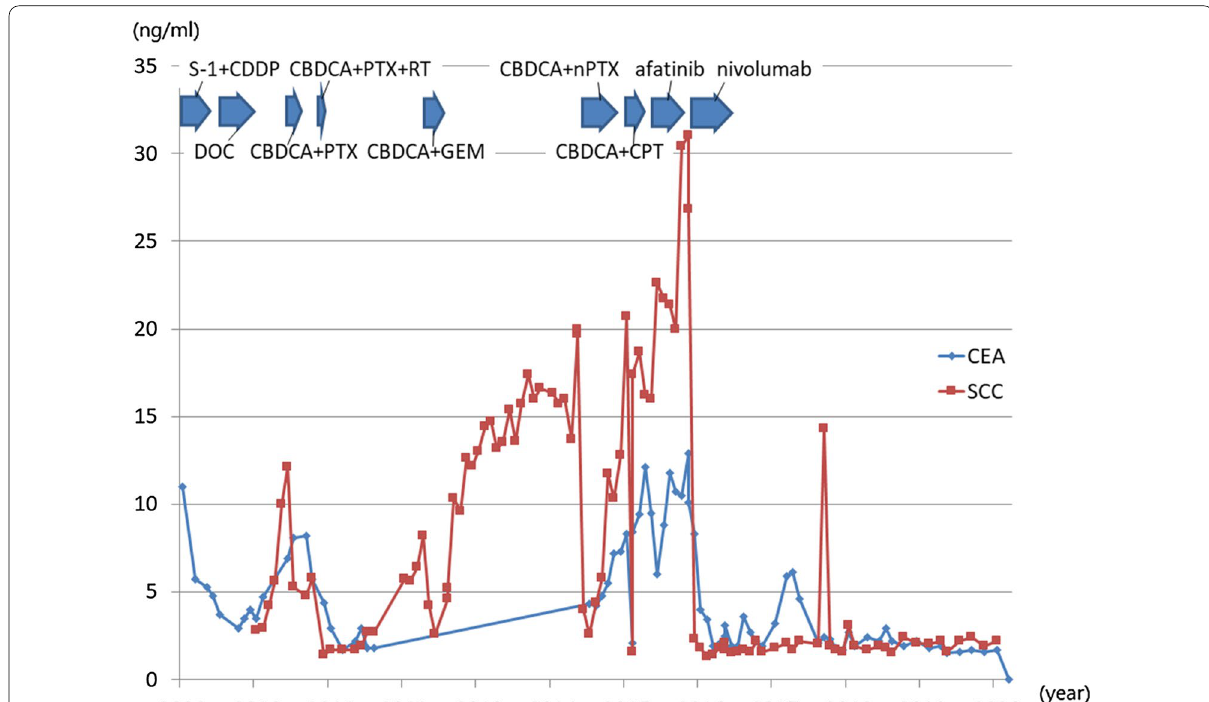
Fig. 3 Changes of tumor markers. CEA carcinoembryonic antigen, SCC squamous cell carcinoma antigen, CDDP cisplatin, DOC docetaxel, CBDCA carboplatin, PTX paclitaxel, RT radiation therapy, GEM gemcitabine, nPTX nab-paclitaxel, CPT irinotecan